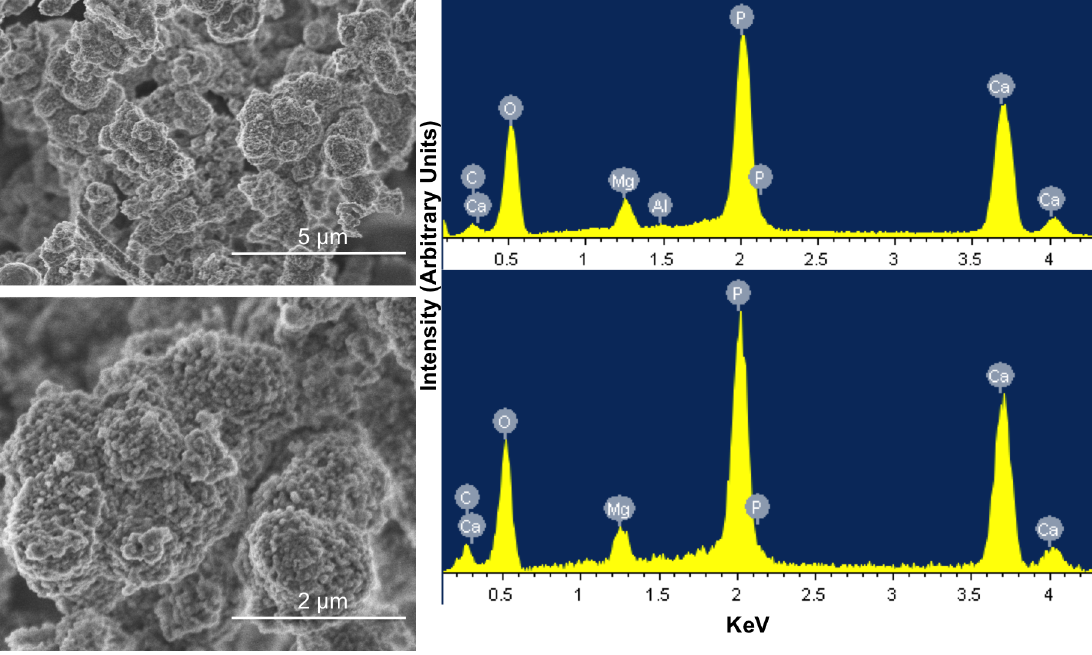
Figure 6. SEM-EDX analysis of two areas from a calcinated precipitate isolated after 30 days of C.hydrogenoformans growth in the DSMZ medium. Images on the left show two levels of magnification of same area. Images on the right show EDX spectrum of two distinct areas of the sample.